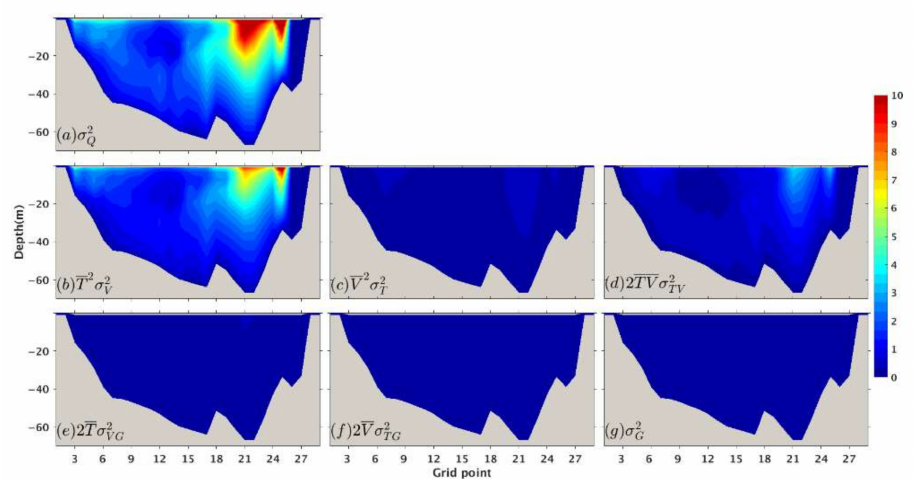
Figure 10. ( a ) denotes the total variance in heat transport across the TAS. ( b – g ) represent the six terms decomposed using Equation (13).